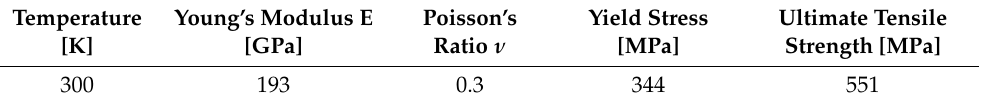
Table 8. Mechanical properties of the electrodeposited nickel as reported in